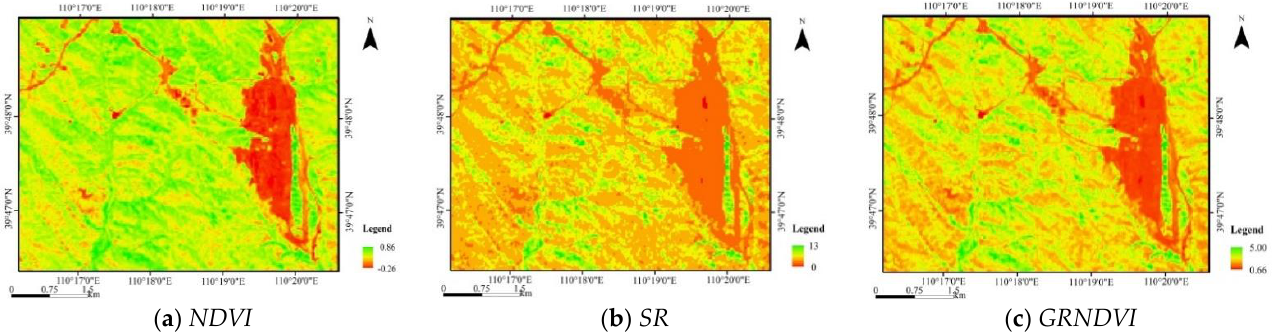
Figure 3. Comparison of the vegetation index NDVI , SR and GRNDVI on 15 August 2014.